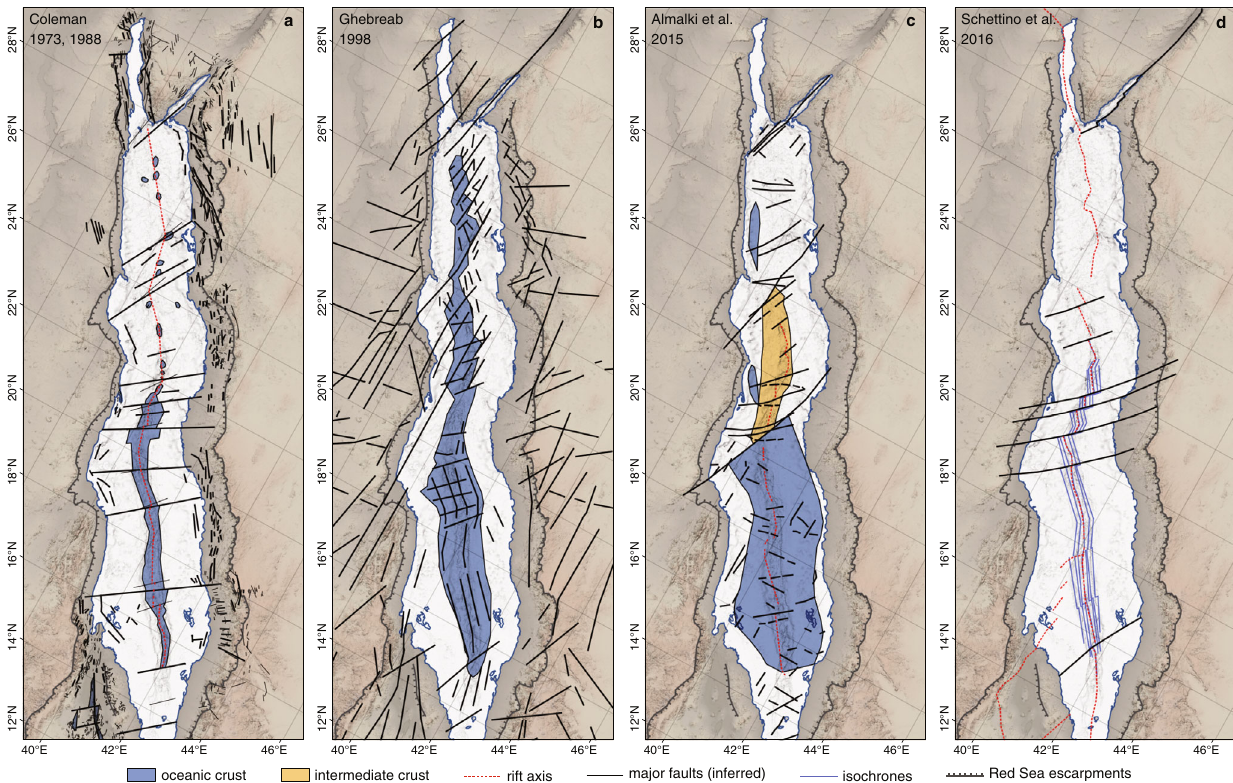
Fig. 2 Diversity of tectonic models of the Red Sea. a Initial models suggested continuous spreading in the south grading northwards into discrete spreading nodes separated by continental crust 4,5 . b Model allowing for oceanic crust along the entire basin 8 . c Model with large areas of intermediate crust in the central Red Sea 6 . d Model limiting oceanic spreading to areas where magnetic isochrones were identi fi ed 7 . Common for all models is the signi fi cant amount of large transform faults and fault zones across the entire